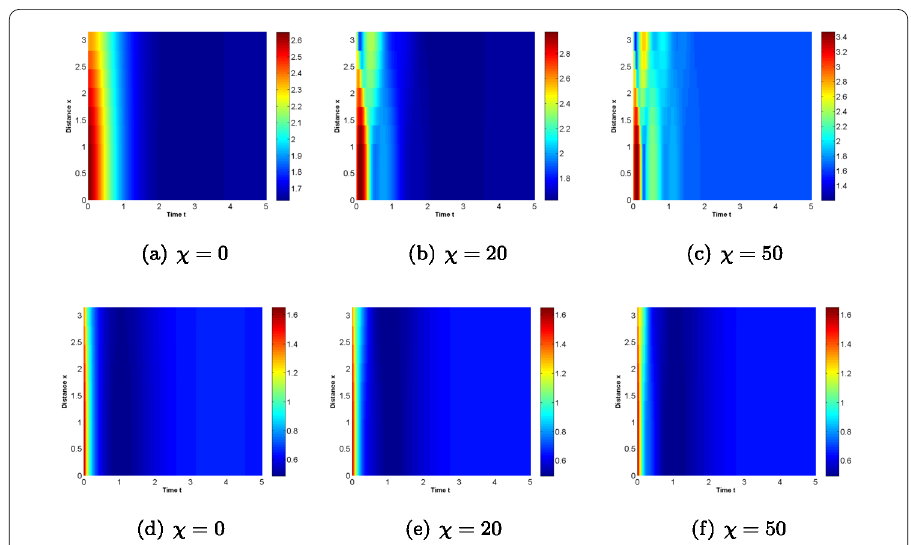
Figure 1 The positive equilibrium ( ¯ u , ¯ v ) ≈ (0.6467,1.6467) for r 0 = 80, p = 1. The first line represents the number of predators, the second line represents the number of prey, the positive equilibrium ( ¯ u , ¯ v ) becomes stable faster with increasing χ